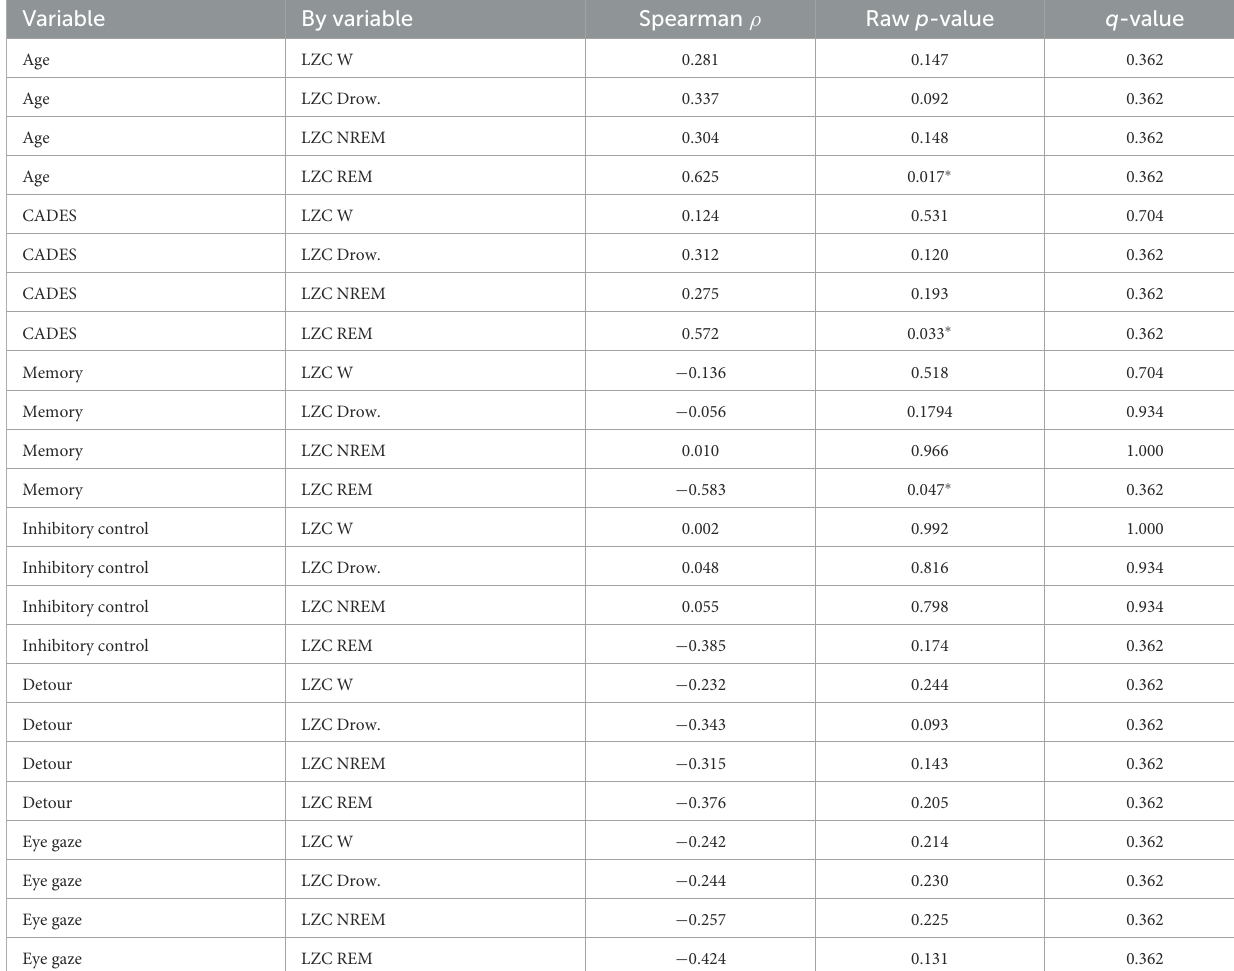
TABLE 3 Correlation between Lempel Ziv Complexity at Cz and age and cognitive function.